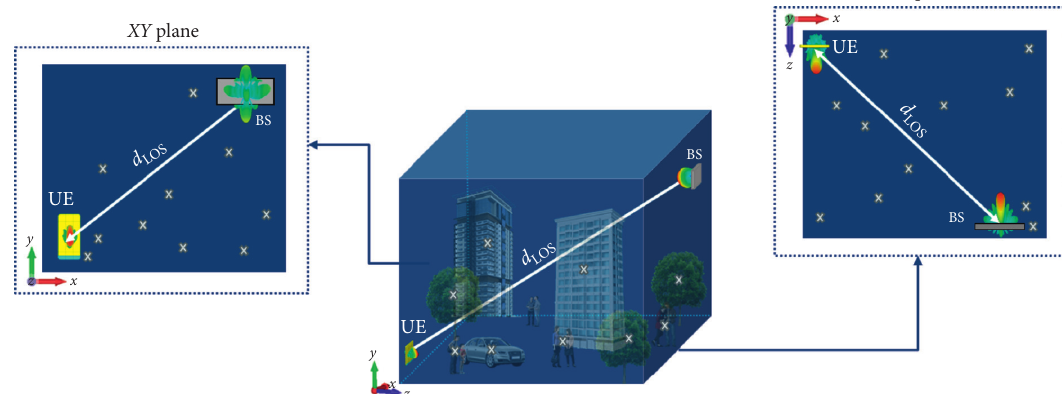
Figure 17: Scatterer depiction in the channel